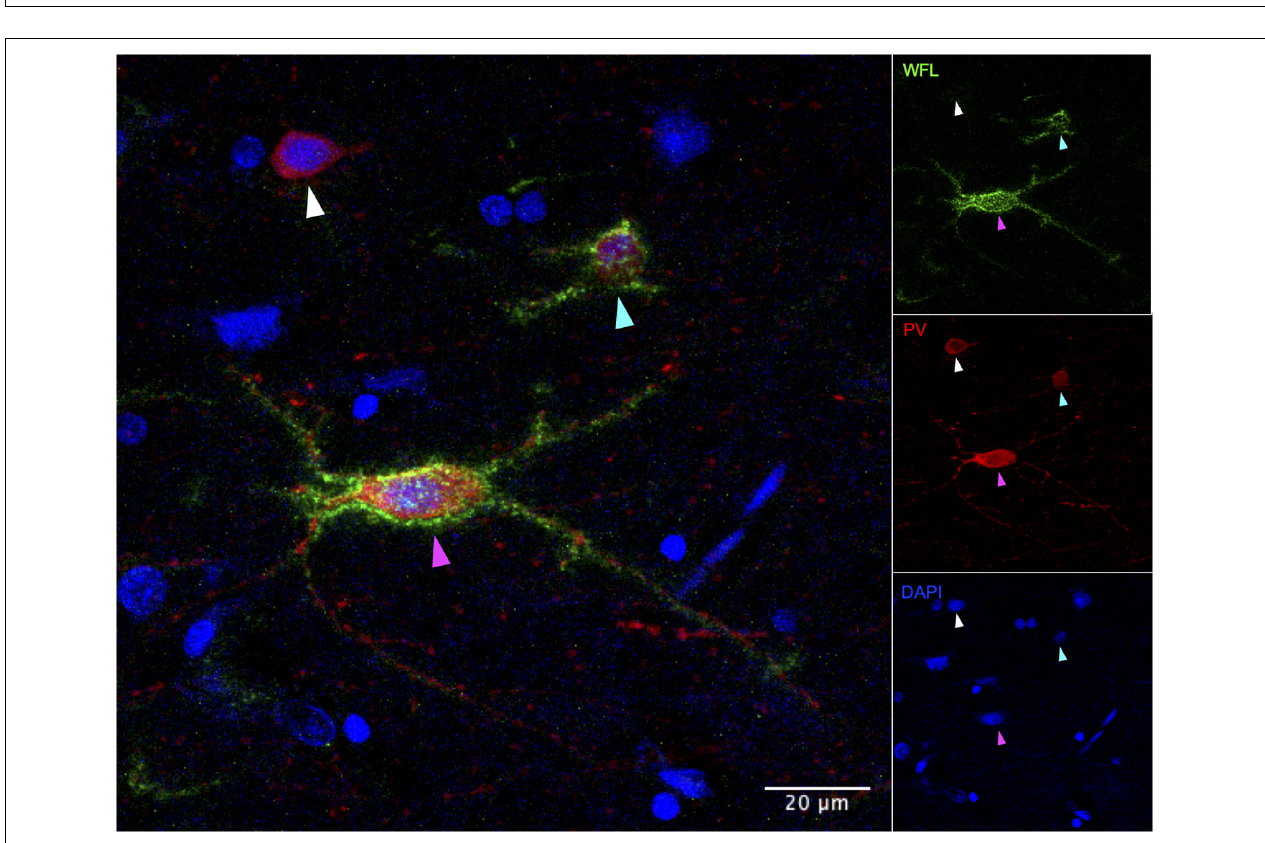
FIGURE 4 | Immunohistochemical detection of parvalbumin positive neurons in post-mortem human vmPFC that are surrounded or not by perineuronal nets. WFL, Westeria Floribunda Lectin; PV, Parvalbumin; DAPI, nuclear staining. White arrow: PV+/PNN– cell, Cyan arrow: PV+/PNN+ low intensity/coverage, Magenta arrow: PV+/PNN+ high intensity/coverage. Images were taken on an Olympus FV1200 laser scanning confocal microscope at 40x magnification.